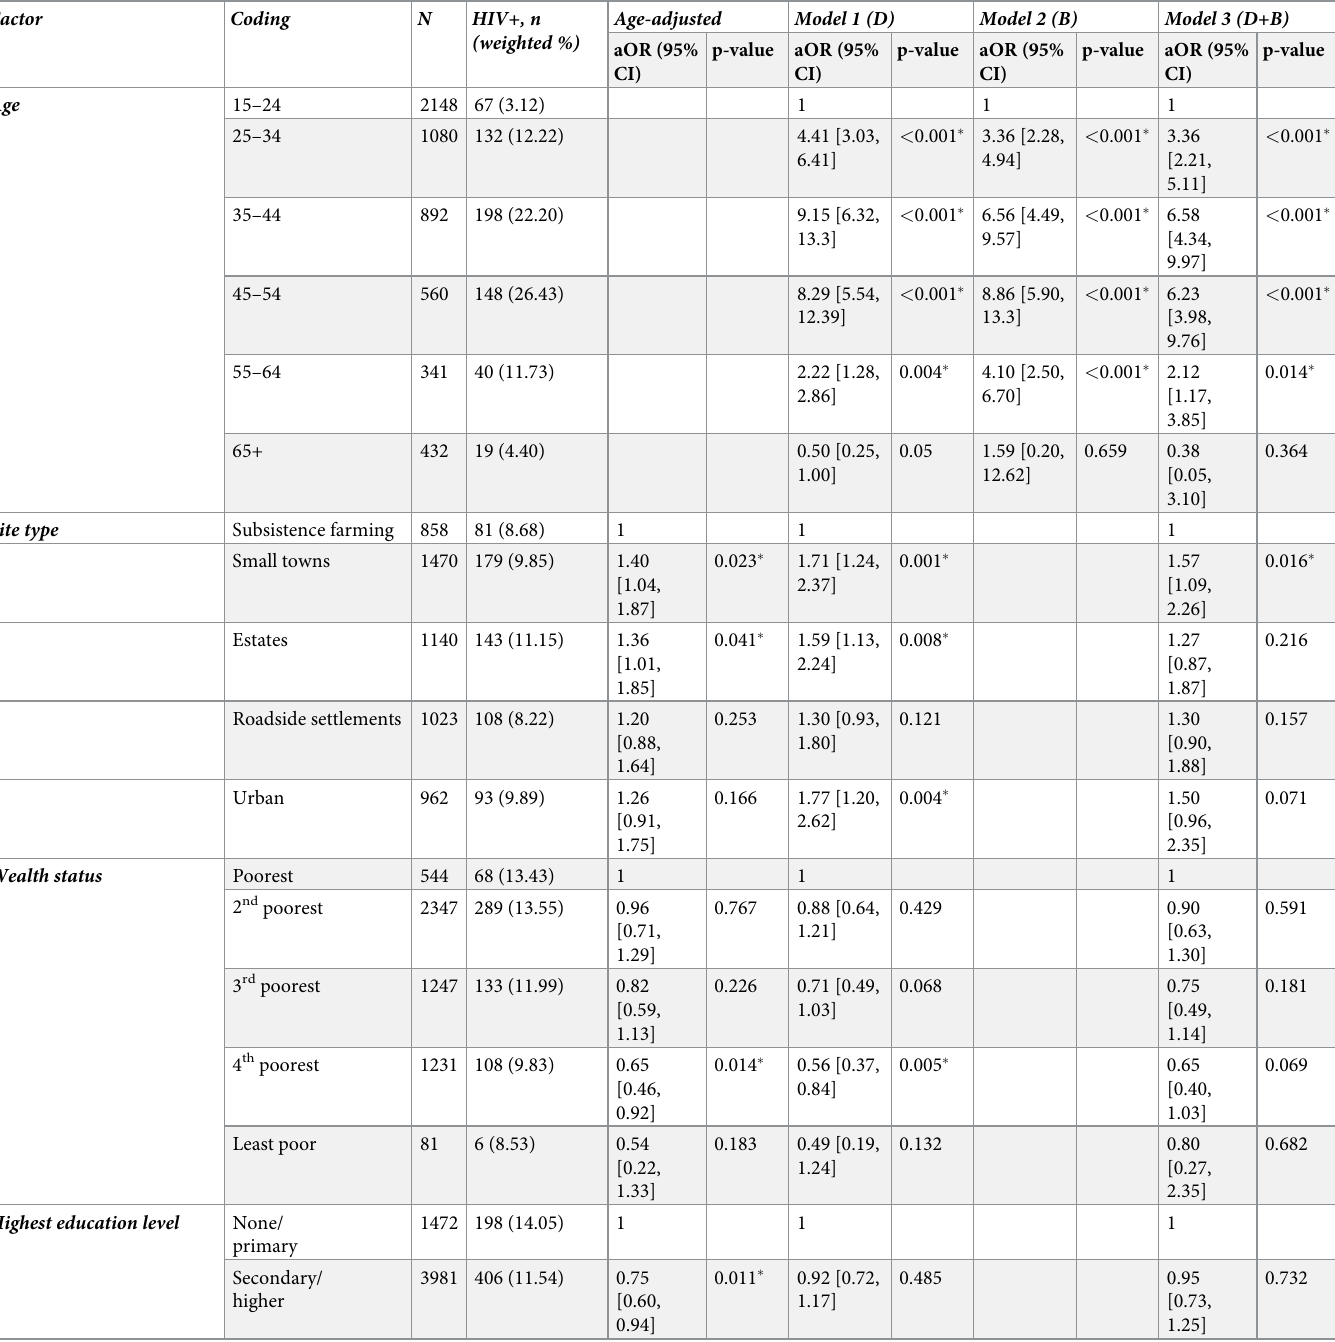
Table 2. Age-adjusted and multivariate models of socio-demographic and behavioural risk factors associated with HIV prevalence in females (N =